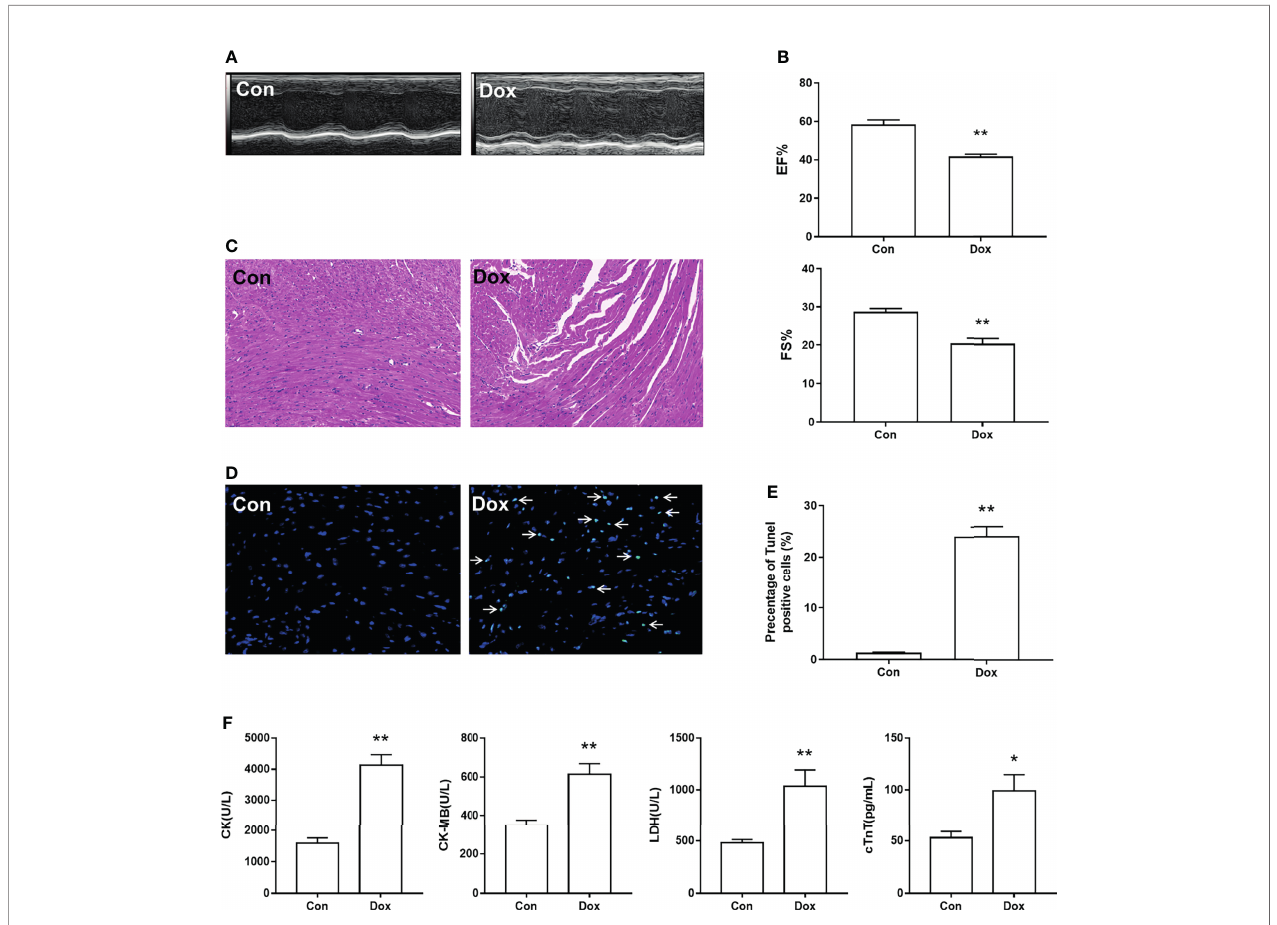
FIGURE 1 | Dox-induced cardiac dysfunction and histological injury. (A) M-mode echocardiograms showing left ventricular dilation induced by Dox. (B) The parameters of left ventricular ejection fraction (EF%) and left ventricular fractional shortening (FS%). (C) H&E staining re fl ected the histological changes, magni fi cation ×200. (D) Representative image of TUNEL staining, magni fi cation ×400; white arrows indicate the apoptotic cells. (E) Statistical result of TUNEL staining. (F) The serum level of creatine kinase (CK), creatine kinase-MB (CK-MB), lactic dehydrogenase (LDH), and cardiac troponin T (cTnT). Con, control; Dox, doxorubicin. Data are mean ± SEM. n = 6 – 10. * p < 0.05, ** p < 0.01 vs.